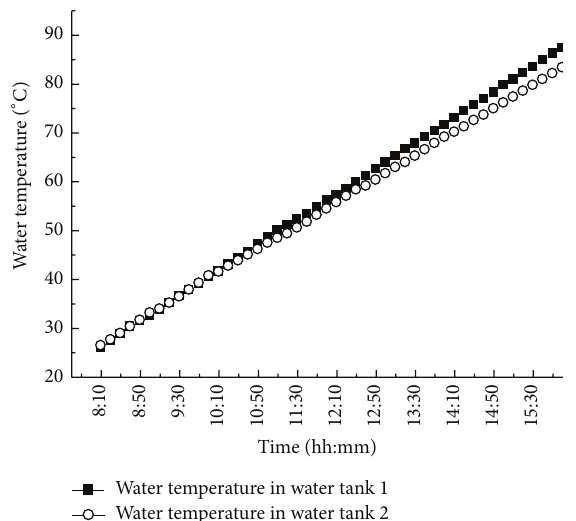
Figure 8: Water temperature in water tank 1 and water tank 2 versus testing